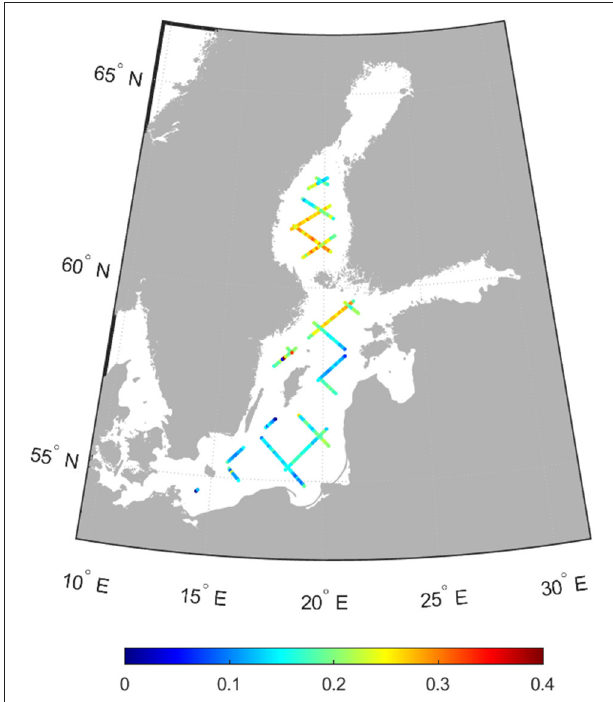
FIGURE 4 | Contribution of NAO to sea level rise (mm/year) of the basin in the altimetry points. The trend map is the result of subtracting the rates estimated by Equation (2) from those of Equation (3). NAO has the highest impact on sea level rise of the Gulf of Bothnia where it reaches 0.4 mm/year. Comparing to the overall magnitude of the sea level trend, however, this figure is not substantial.